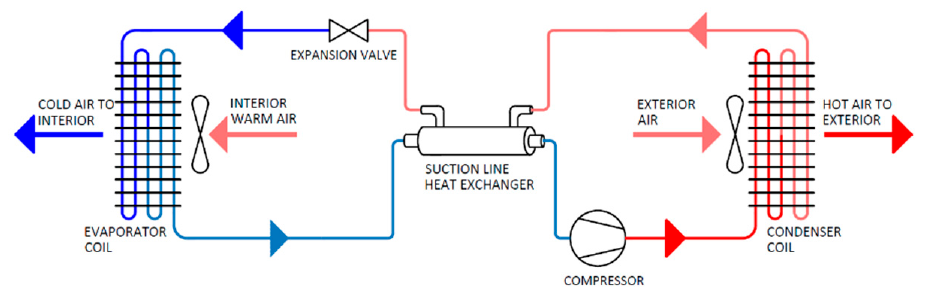
Figure 5. The schematic of a basic heat pump refrigeration cycle with a suction line heat exchanger.